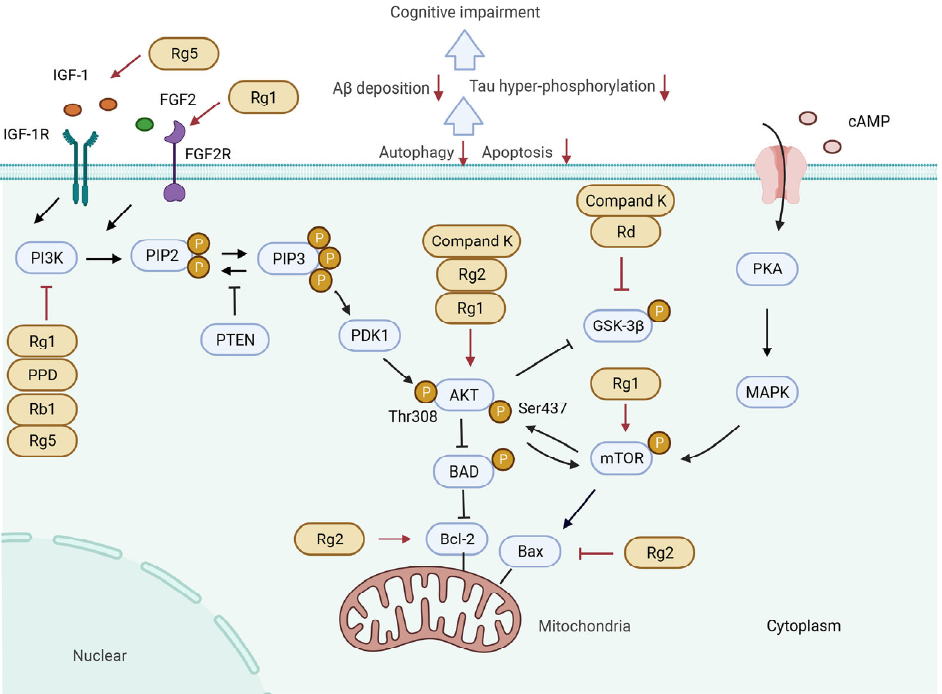
Figure 3. Molecular mechanisms of regulating PI3K/Akt signaling pathway by ginsenosides in treating cognitive impairment in the pathological model. ( 1 ) Rg5 and Rg1 activate PI3K/AKT pathway by stimulating IGF ‐ 1 and FGF2, perhaps eventually reducing A β deposition and tau hyperphosphorylation by inhibiting GSK ‐ 3 β . Moreover, compound K, Rg2, and Rg1 can activate phosphorylation of AKT to reduce the content of GSK ‐ 3 β . In addition, compound K and Rd directly attenuate GSK ‐ 3 β to further inhibit A β deposition and tau hyperphosphorylation. ( 2 ) PI3K can be inhibited by Rg1, PPD, Rb1, and Rg5, further promoting the expression of anti ‐ apoptotic protein Bcl ‐ 2, and increased the Bcl ‐ 2/Bax ratio to attenuate cell apoptosis. Additionally, Rg2 can directly promote the expression of Bcl ‐ 2. ( 3 ) Rg1 increases the expression of p ‐ Akt and p ‐ mTOR to inhibit mTOR ‐ medicated autophagy.